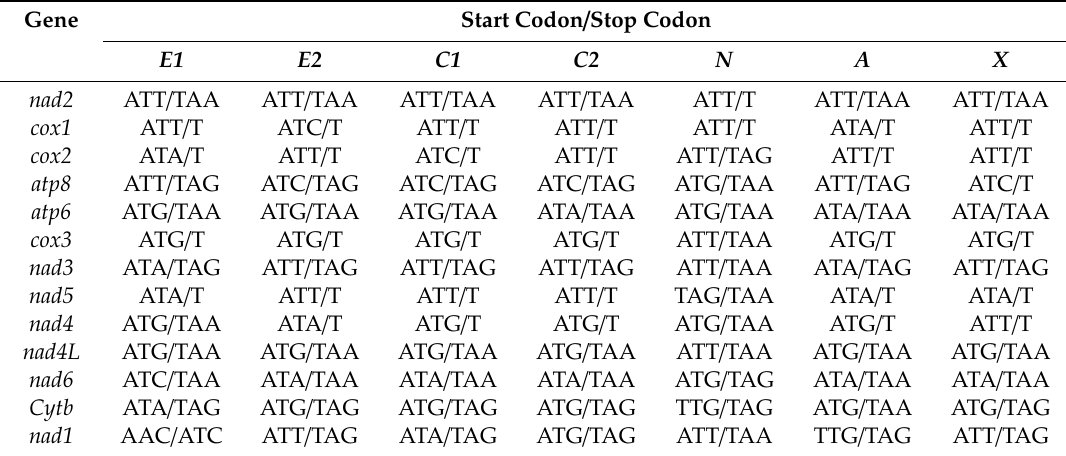
Table 5. Start and stop codons of the mitochondrial genomes: E. guttata ( E1 ), Epuraea sp. ( E2 ), C. dimidiatus ( C1 ), C. pilosellus ( C2 ), Nitidulidae sp. ( N ), A. tumida ( A ), and X. variegatus ( X